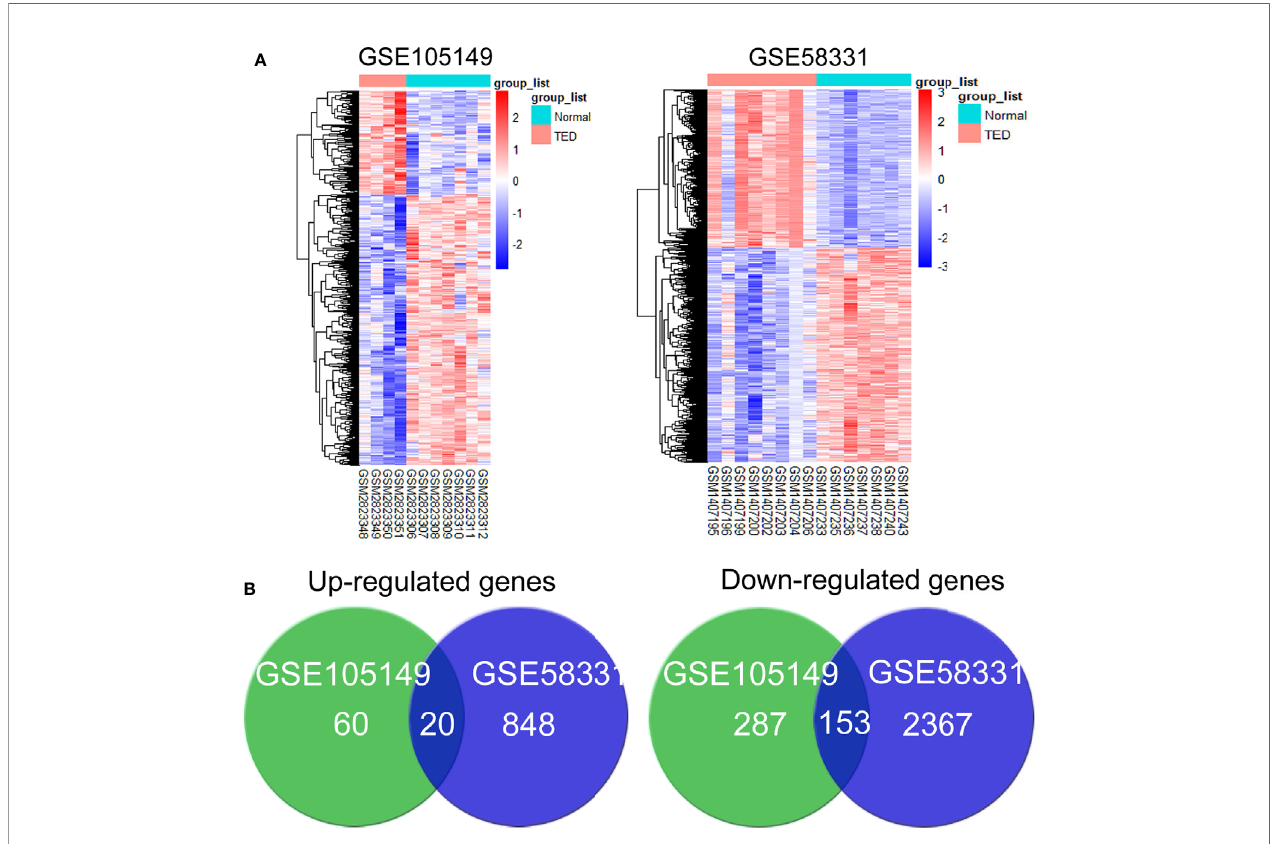
FIGURE 1 | Screening of the common differentially expressed genes associated with lacrimal enlargement in thyroid eye disease (TED). (A) hierarchical clustering heat maps showed different expression of all differentially expressed genes (DEGs) in the TED lacrimal samples relative to normal lacrimal samples. Red indicates that the expression of genes is relatively upregulated, and blue indicates that the expression of genes is relatively downregulated. (B) The DEGs were identi fi ed with the P-value <0.05 and |log (fold change) ≥ 1 between thyroid eye disease (TED) and normal lacrimal samples from the mRNA expression pro fi ling sets GSE105149 and GSE58331. Venn diagram showed the respective frequency of up-regulated and down-regulated genes in the TED lacrimal